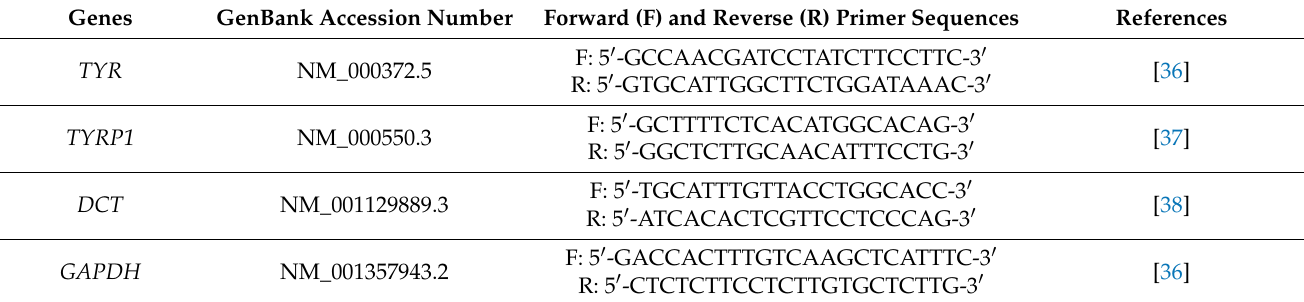
Table 2. Sequences of primers used for quantitative reverse transcriptase-polymerase chain reaction (qRT-PCR).